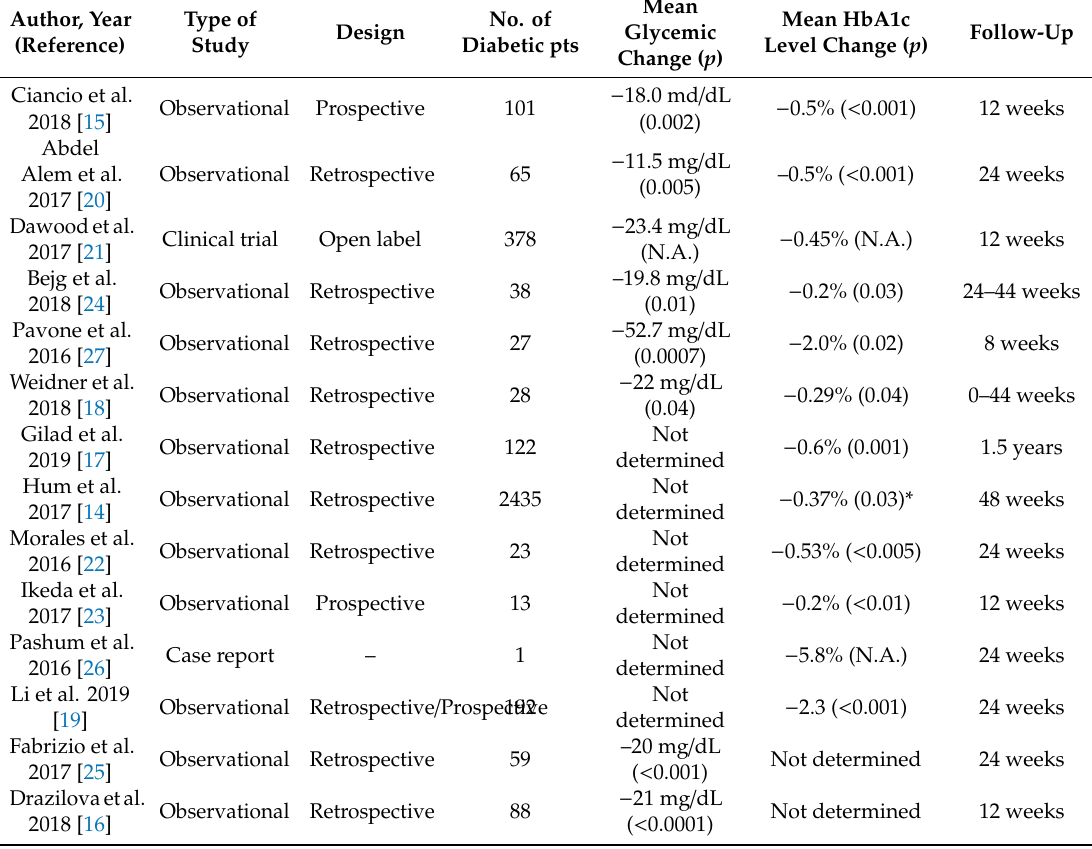
Table 3. Studies reporting significant glycometabolic improvement in DAA-treated HCV-positive patients with SVR.